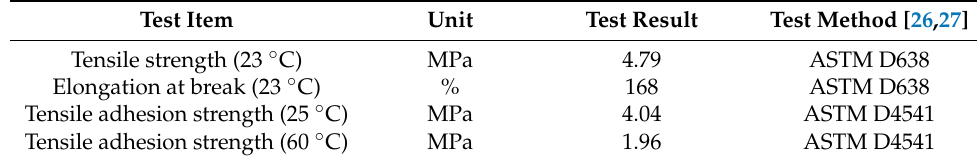
Table 3. Technical parameters of epoxy resin after curing.